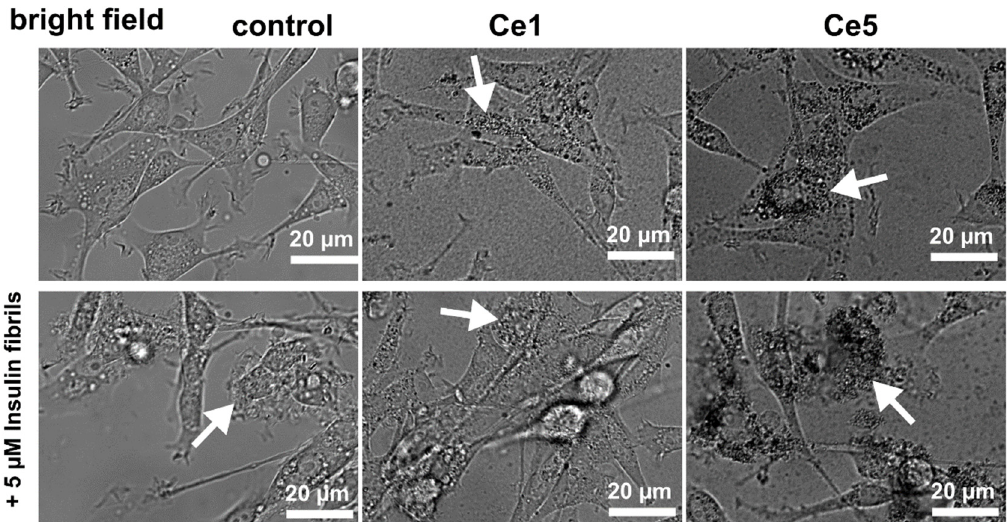
Figure 6. Representative bright-field images of U87 MG cells were subjected to 150 μ g/mL of Ce1 or Ce5 nanoparticles and 5 μ M insulin fibrils (second row) for 24 h. White arrows point to nanoparticle and fibril localization.